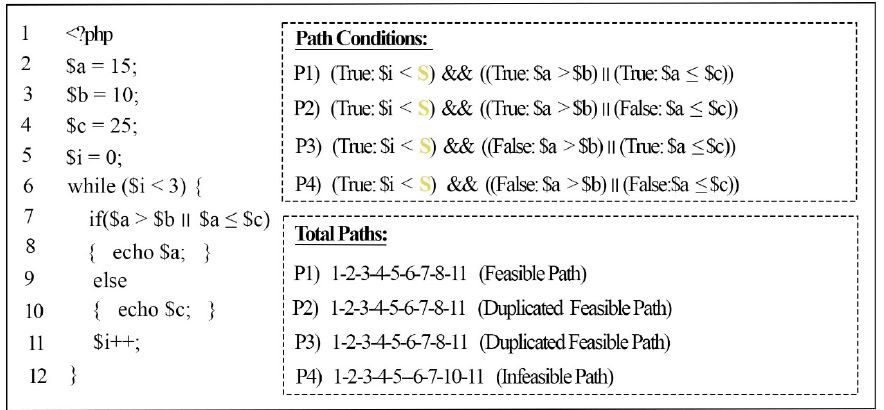
Figure 7. Assigning a symbolic inputs for the loop condition to be executed